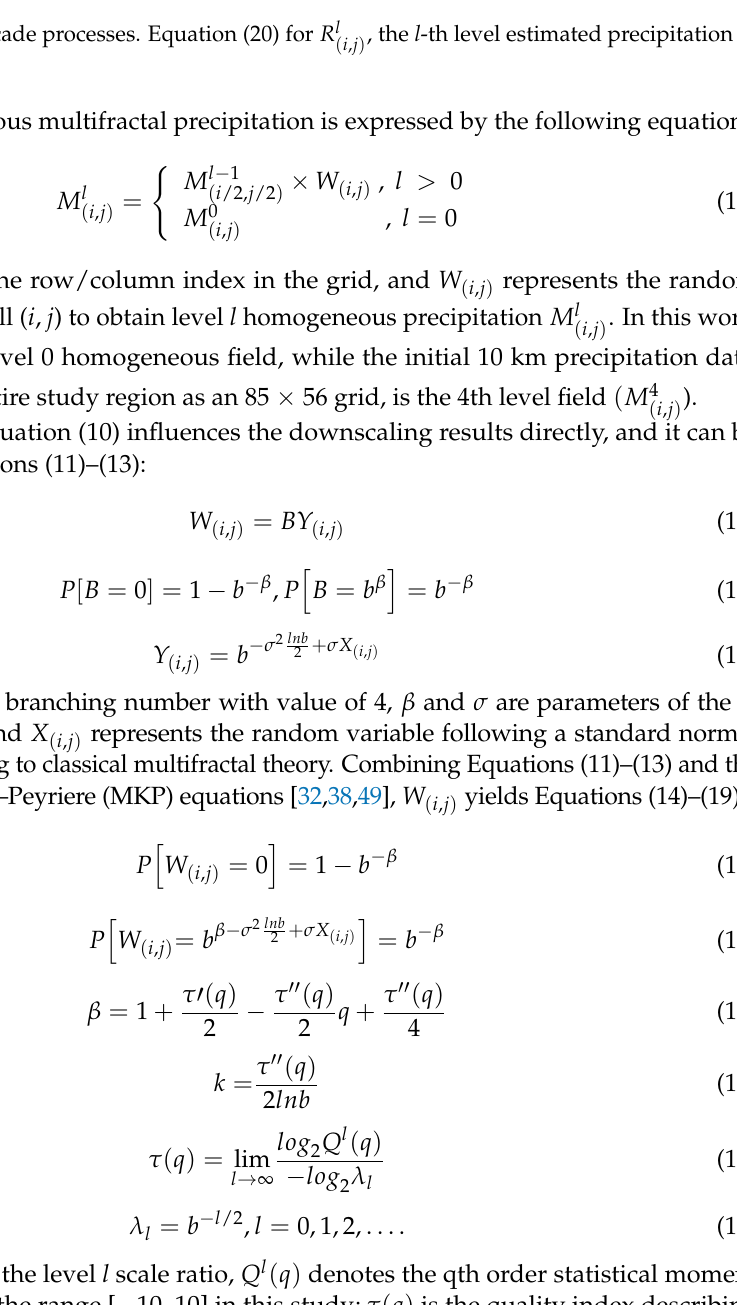
, the l -th level estimated precipitation in ( i , j )